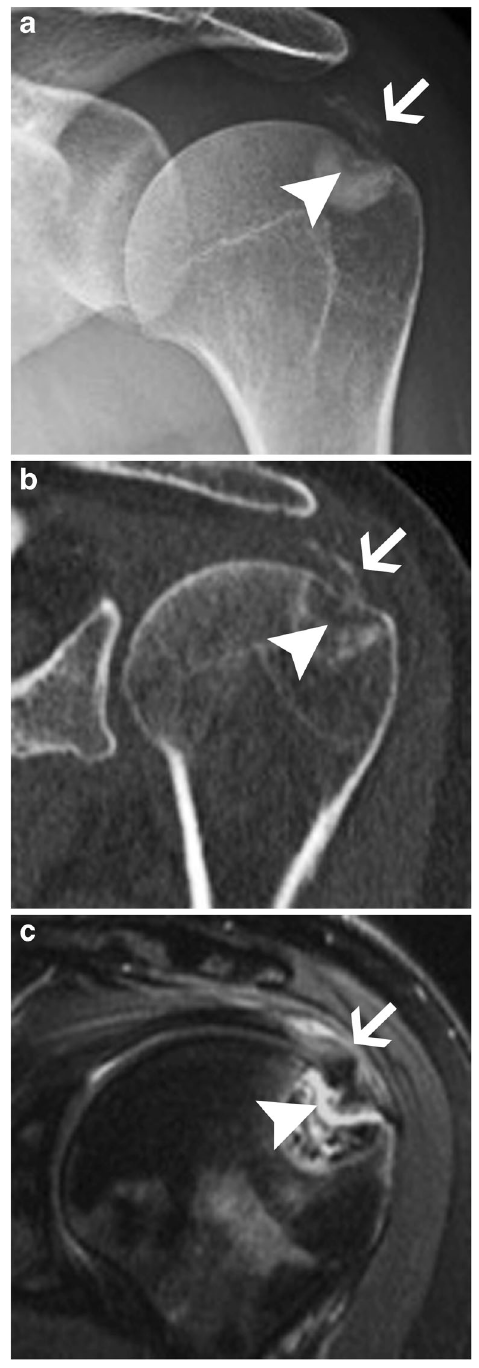
Fig. 6 Supraspinatus calcifying tendinopathy with intraosseous extension. ( a ) Frontal radiograph, ( b ) coronal reformat CT image and ( c ) coronal fat-saturated T2-weighted image show supraspinatus amorphous calcifications (arrows) with intraosseous extension causing erosions (arrowheads). Note the sclerosis around the erosion, hyperdense in ( a ) and ( b ) and hypointense in ( c )